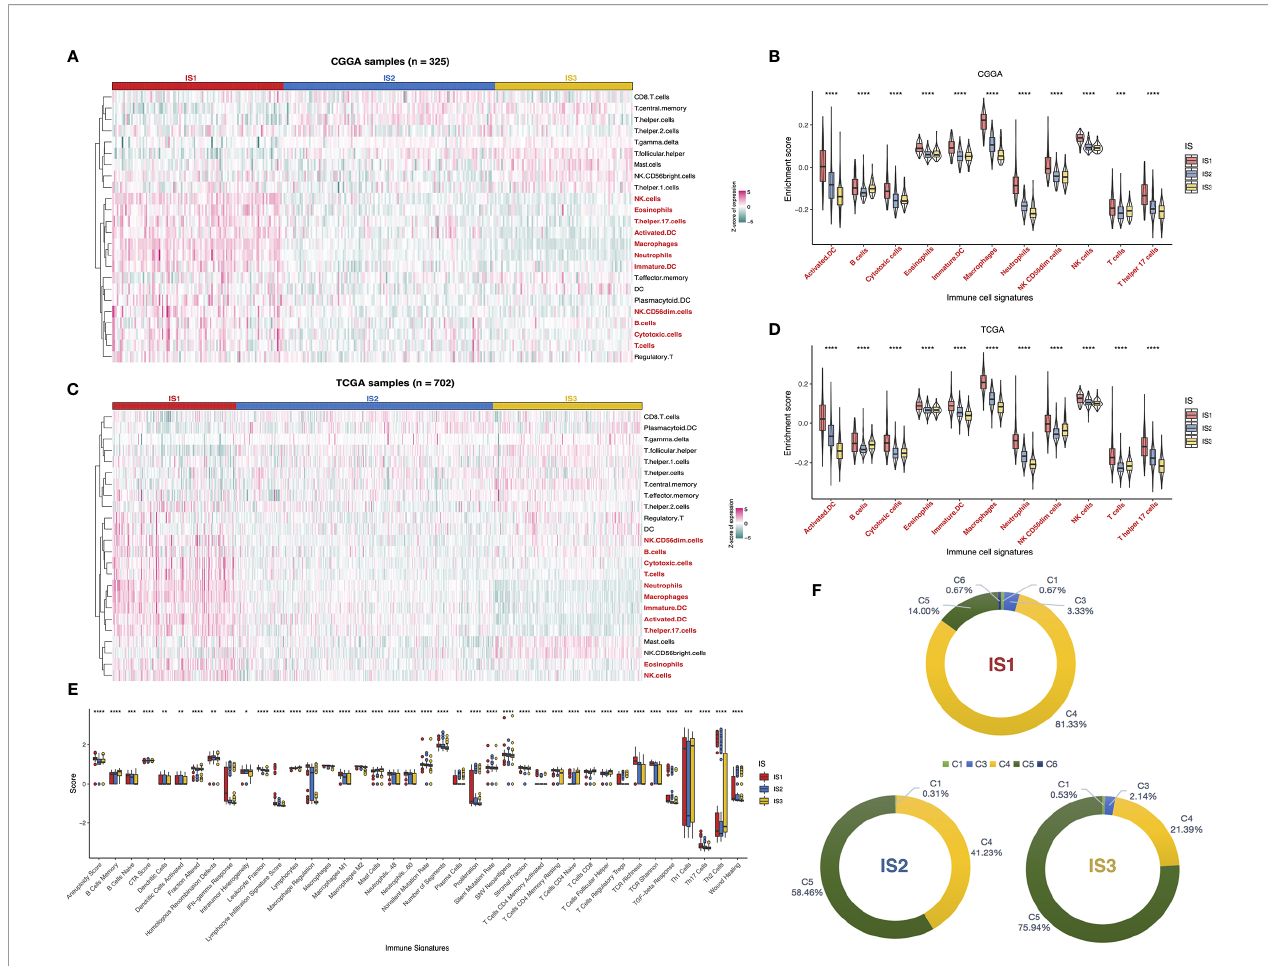
FIGURE 7 | Cellular and molecular characteristics of immune subtypes. Differential enrichment scores of 24 immune cell signatures among glioma immune subtypes in CGGA (A) and TCGA (C) cohorts. Differential enrichment scores of 11 immune cell signatures enriched in IS1 across CGGA (B) and TCGA (D) cohorts. Differential enrichment scores of 56 immune signatures among glioma immune subtypes and 40 signi fi cant immune signatures with p-value<0.05 (E) . Overlap of three immune subtypes with six pan-cancer immune subtypes in glioma (F) . *p < 0.05, **p < 0.01, ***p < 0.001, and ****p <